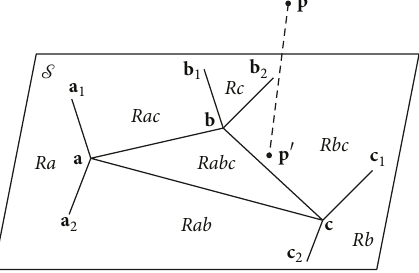
Figure 4: Different types of distances between a point p and a triangle abc